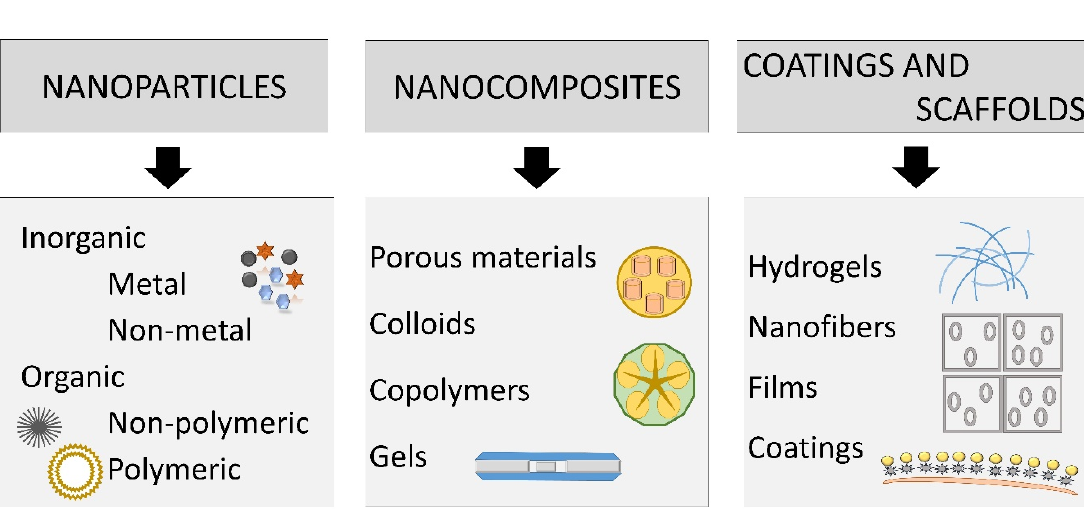
Figure 2. Main types of nanomaterials which can be used for wound treatment.